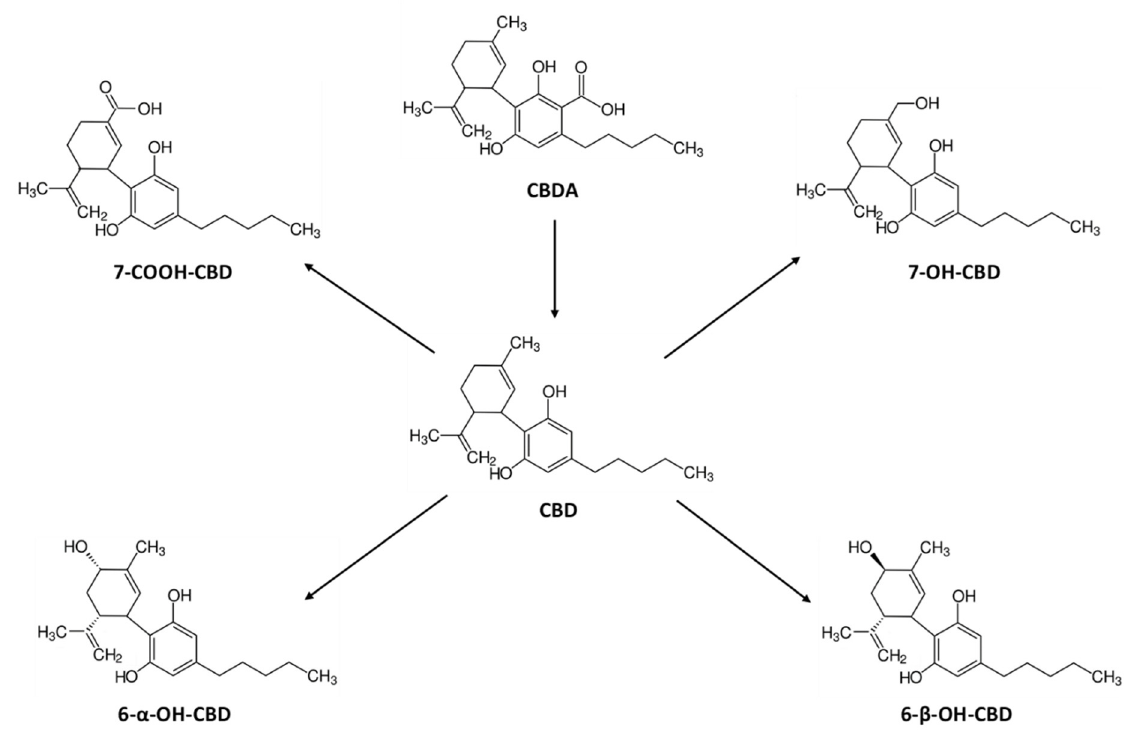
Figure 2. Chemical structures of cannabidiol (CBD), its acidic precursor, and its metabolites.